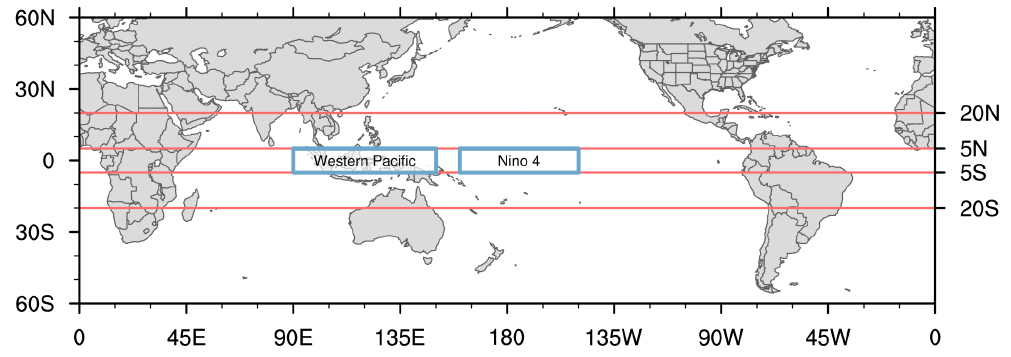
Figure 3. The two boxes showing the two regions, the equatorial western Pacific (5°S–5°N, 90–150°E) and the Niño 4 domain in the central Pacific (5°S–5°N, 160°E–150°W), analyzed in Figure 2. The latitude zones (5°S–5°N and 20°S–20°N) that are analyzed in other figures are also marked. Hovmöller analysis is a useful tool in displaying details of spatial variability in a time series. Figure 4 shows longitude–time evolutions of monthly UTH (left panel) and TCWV (right panel) anomalies around the equator, averaged between 5°S and 5°N. The stripes near 30°E and 60°W in the TCWV panel indicate land surfaces over which TCWV data are unavailable. The onset of the 1997– 98 El Niño, as defined by the Oceanic Niño Index (ONI) (calculated using the three-month running mean of Extended Reconstructed Sea Surface Temperature (ERSST) v5 [47] SST anomalies in the Niño 3.4 region (5°N–5°S, 120°–170°W)), started in May 1997. Both the TCWV and UTH series show that preceding this El Niño event (at the end of 1996), there was a positive anomaly of water vapor near the dateline. This is consistent with the finding of higher water vapor concentration in previous studies of the 1997–98 El Niño [48–50]. The studies linked the higher water vapor to a build-up of heat content in the atmosphere due to stronger-than-normal trade winds associated with a weak La Niña in 1995–96. Soon after the onset of the 1997–98 El Niño, positive anomalies of TCWV rapidly extended from the dateline to the eastern end of the equatorial Pacific. However, the shift of positive anomalies in the UTH field that started at the dateline to the eastern Pacific was more gradual through the course of the El Niño event, resulting in a lag behind the TCWV positive anomalies in the eastern Pacific. As the water vapor built up all the way from the lower atmosphere (implied by TCWV) to the upper troposphere (marked by UTH) at the peak of the El Niño, there was also a significantly increased water vapor mixing ratio at 215 hPa over the eastern Pacific [51], indicating that the deep convection extended to the tropopause. During the time of water vapor increase in the eastern Pacific, a dry region developed in the western Pacific in both the TCWV and UTH fields. The UTH panel shows that the 1982–83 and 1997–98 El Niño events evolved in similar patterns, but the 2015–16 event was different from the earlier two major events. Unlike the previous events, there was a notable increase of water vapor at the eastern end of the Pacific for the 2015–16 event at about the same time as the onset of the UTH increase near the dateline. The overall intensity of the UTH increase in the 2015–16 event was not as strong as that in the previous two major events. 3.2. Anomalies during Major El Niño and La Niña Events The spatial anomalies of UTH and TCWV during major El Niño and La Niña events are shown in Figures 5 and 6. In the time series of the HIRS UTH, there were three very strong El Niño events (1982–83, 1997–98, and 2015–16). During these events, several SST anomaly indices, including the commonly used ONI, Niño 3 Index, Niño 3.4 Index, and Niño 4 Index, exceeded 2 °C. Figure 5a–c displays UTH anomalies averaged over six months in the peak of the three El Niño events, respectively. The six months are determined based on the largest anomalies in ONI (available at: http://www.cpc.ncep.noaa.gov/products/analysis_monitoring/ensostuff/ensoyears.shtml).